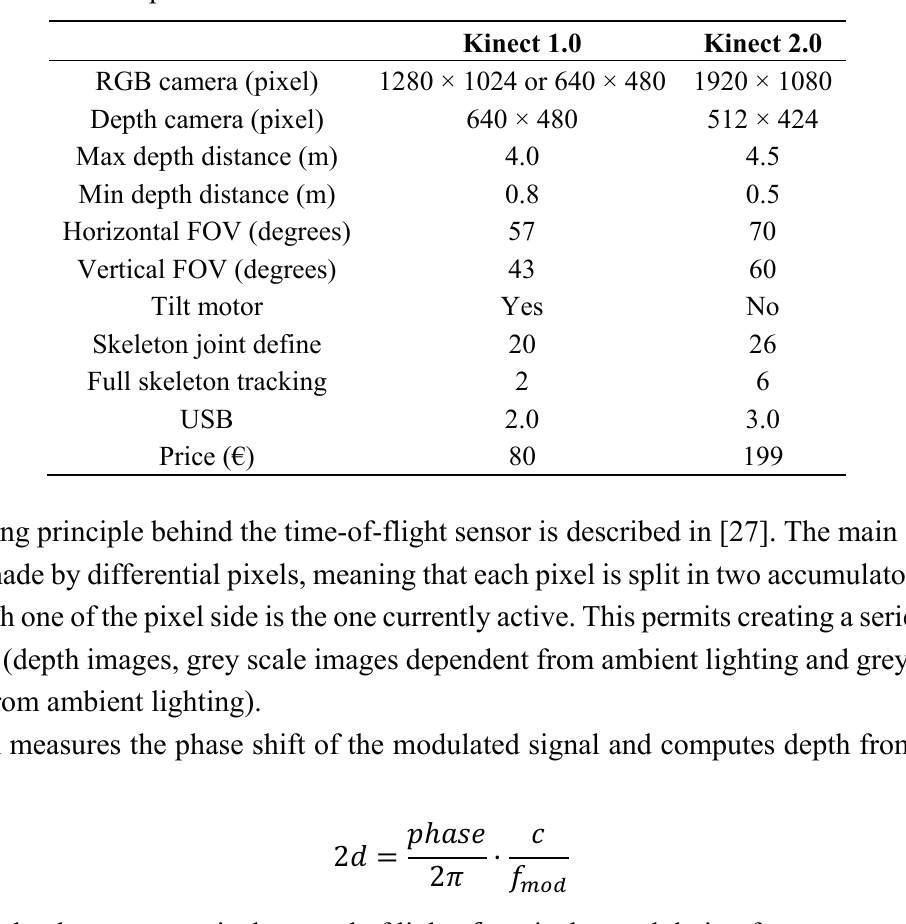
Figure 2. Kinect 2.0 RGB and IR cameras FOV. In blue is represented the FOVs of the IR camera, while in green is represented the FOVs of the RGB camera. Table 1. Comparison between Kinect 1.0 and Kinect 2.0 main